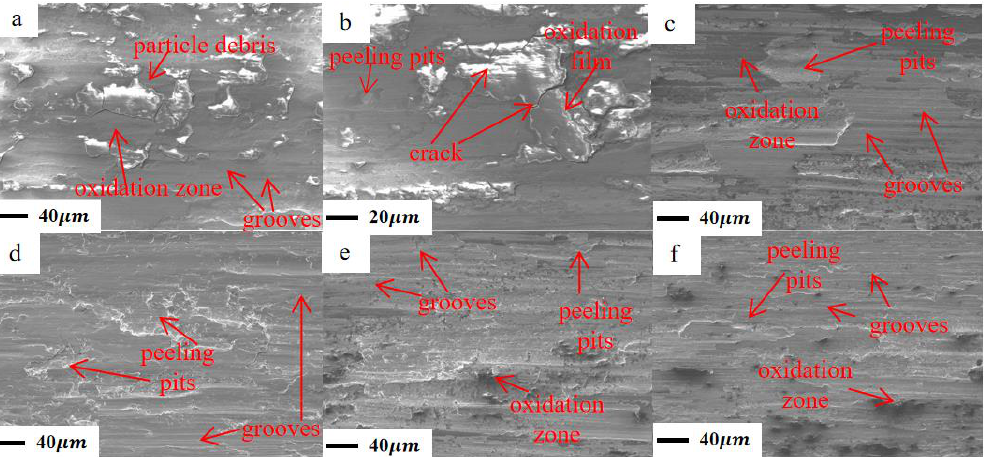
Figure 14. SEM Image of Wear Surface under Different Specimens: ( a ) and ( b ) base metal, ( c ) 700 mA, ( d ) 720 mA, ( e ) 740 mA, ( f ) 760 mA.